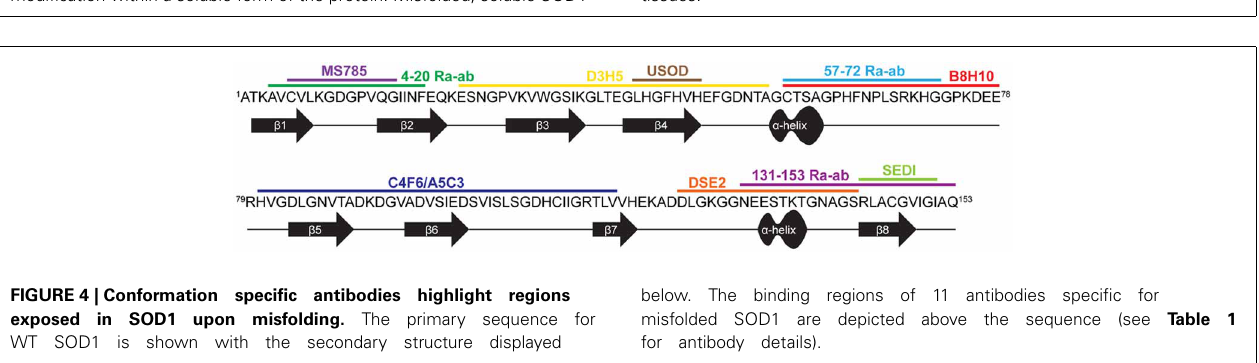
can engage in aberrant protein-interactions and acquire new toxic functions (illustrated in Figure 5 ). Misfolded SOD1 can also assemble into aggregates. In this review, “aggregates” refer to those insoluble species characteristic of end-stage pathological inclusions present in human post-mortem CNS tissues.